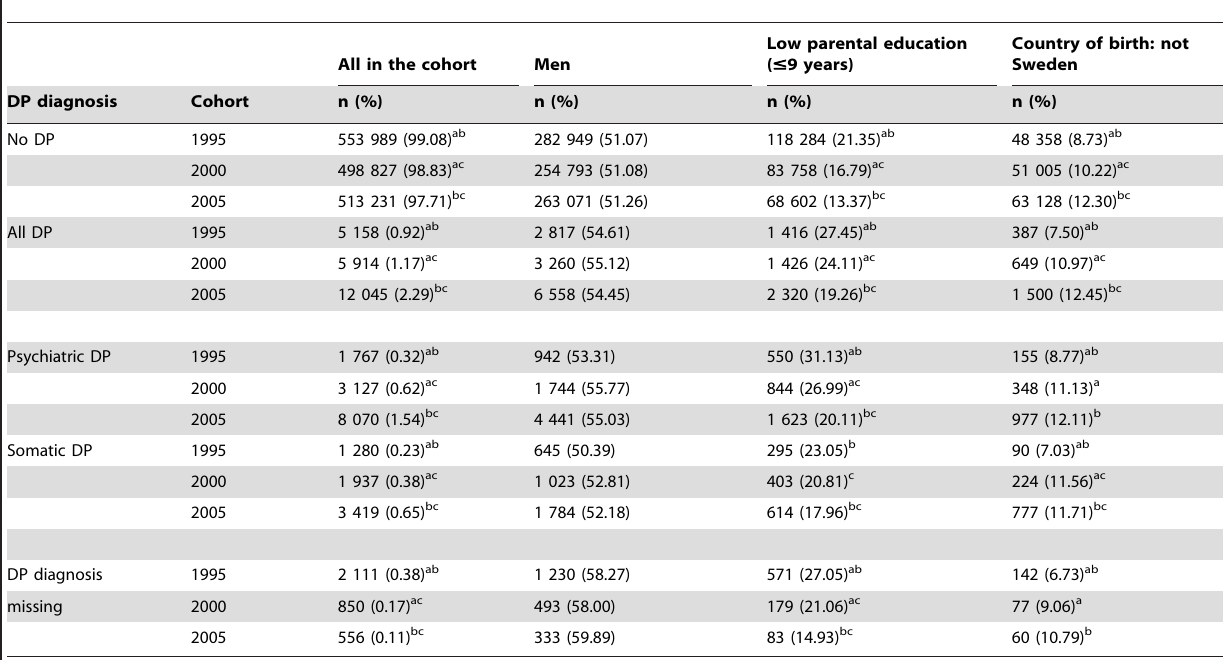
Table 1. Demographic data for young adults 19–23 years old with and without disability pension (DP) in the three studied cohorts of 1995, 2000, and 2005,